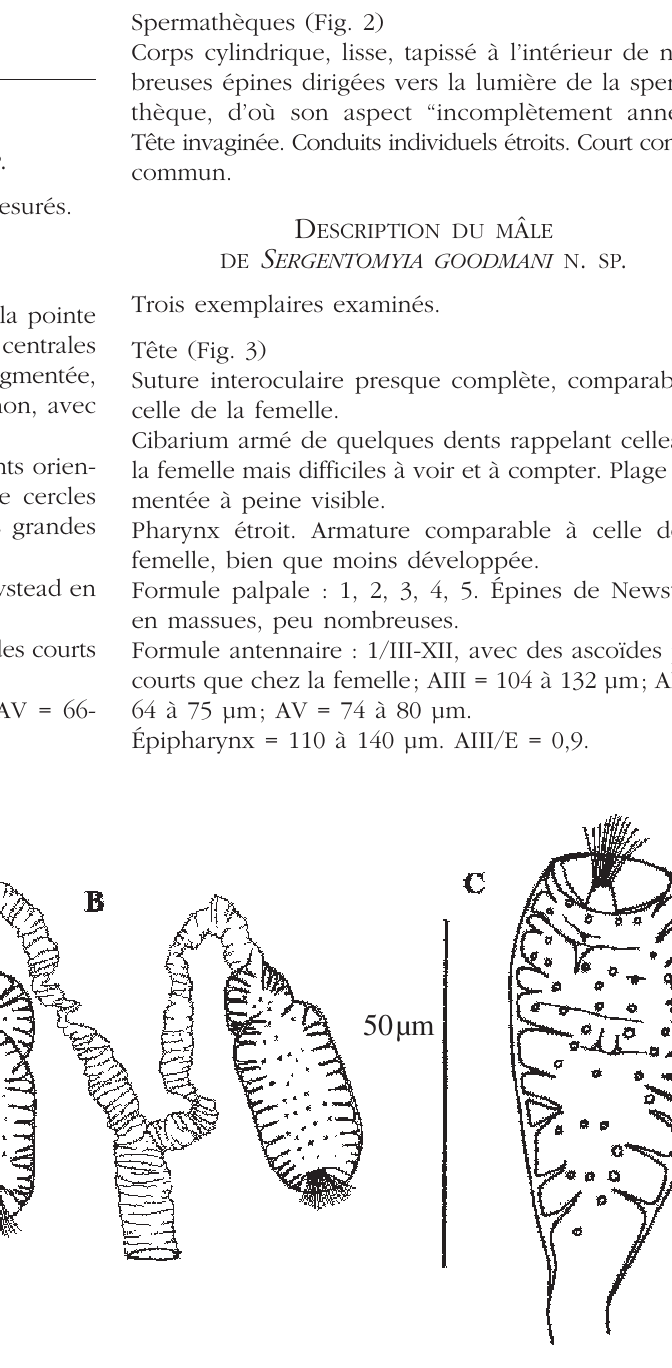
Fig. 2. – S. goodmani n. sp. femelle. A : furca et armature de l’atrium génital; B : spermathèques complètes aprèsmontage dans le Baume du Canada; C : corps et tête de la spermathèque (montage provisoire dans le liquide de